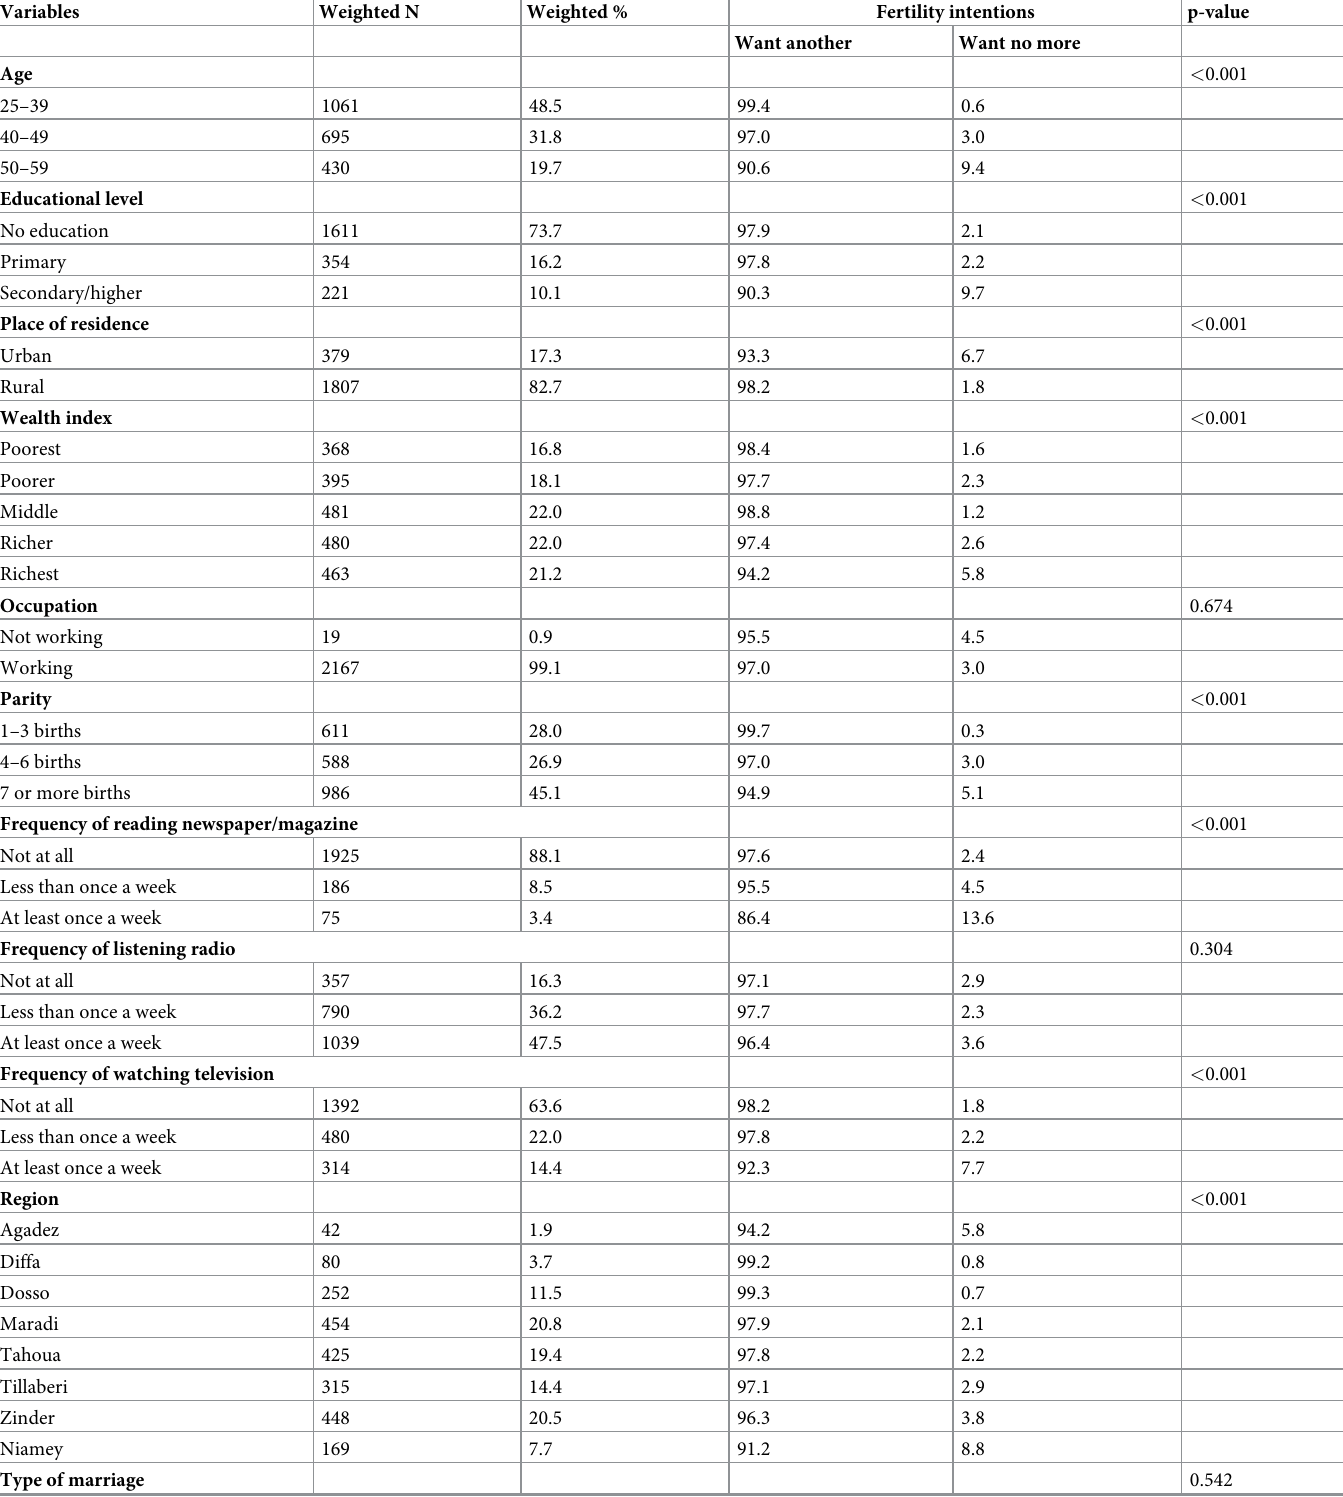
Table 2. Distribution of fertility intentions across socio-demographic characteristics of childbearing men in Niger (weighted).